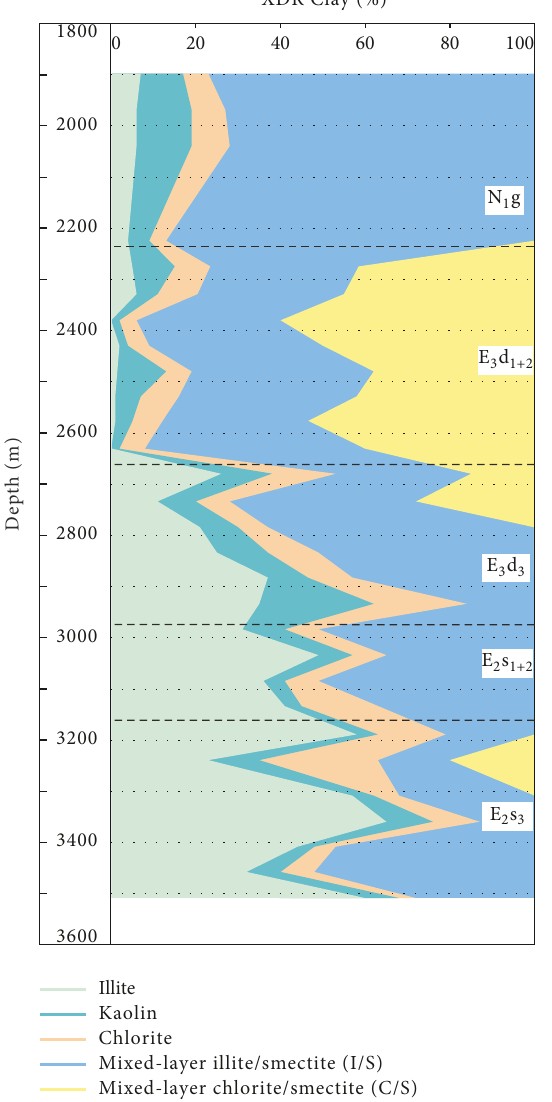
Figure 8: Mineralogical composition vertical distribution of interbedded mudstones based on XRD analysis.